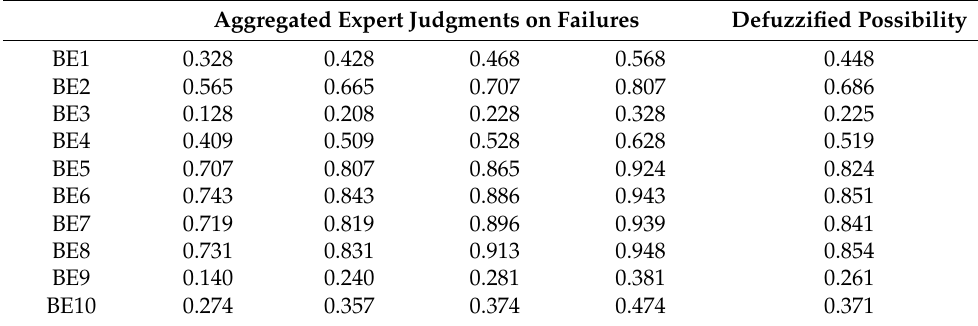
Table 9. Defuzzified values obtained by aggregating possibilities.